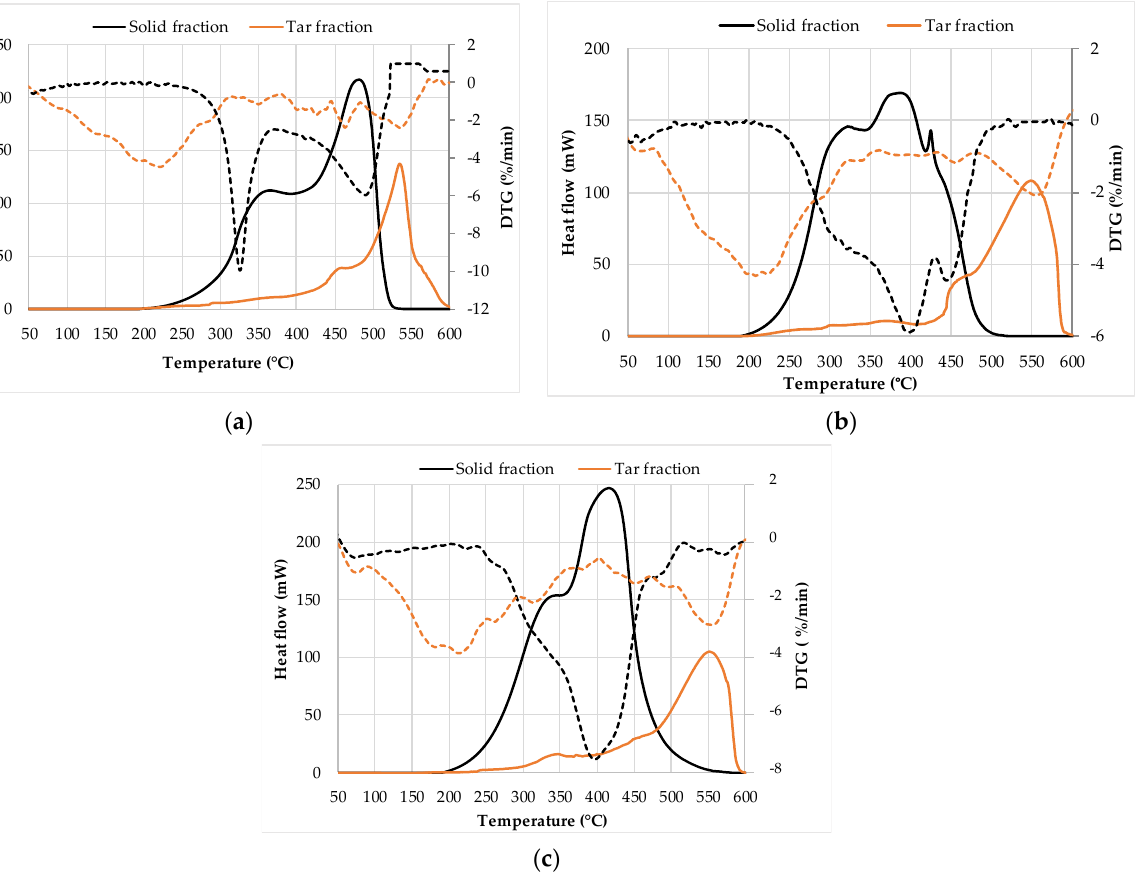
Figure 8. DTG (dashed line) and DSC (unbroken line) curves of the solid and tar fractions that were obtained from different types of biomass by MW-assisted torrefaction at 300 °C: ( a ) softwood, ( b ) wheat straw, and ( c ) peat.